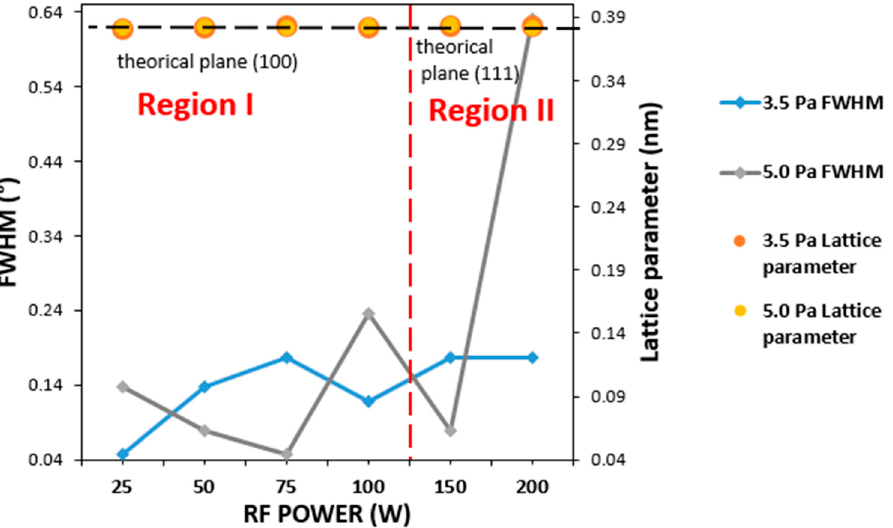
Figure 4. FWHM and lattice parameters extracted from the XRD spectra of Cu 3 N films deposited at the gas pressures of 3.5 Pa and 5.0 Pa and the different RF powers of 25 W to 100 W (region I) and 150 W and 250 W (region II).